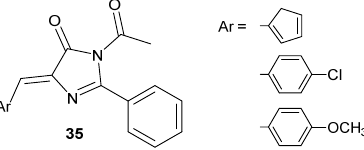
Figure 32. GFPc analogues with a chelating pocket selective for cobalt cations [6].